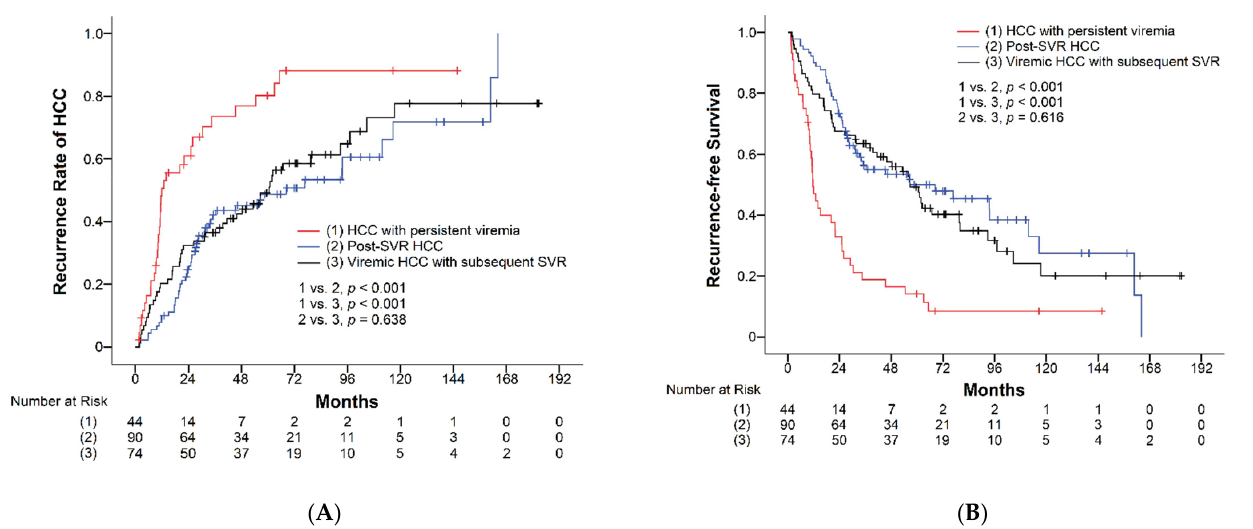
Figure 2. ( A ) Cumulative recurrence rates and ( B ) recurrence-free survival of HCV-related HCC based on viral status. Table 2. Prognosis of the 208 patients with HCV-related early-stage HCC based on HCV